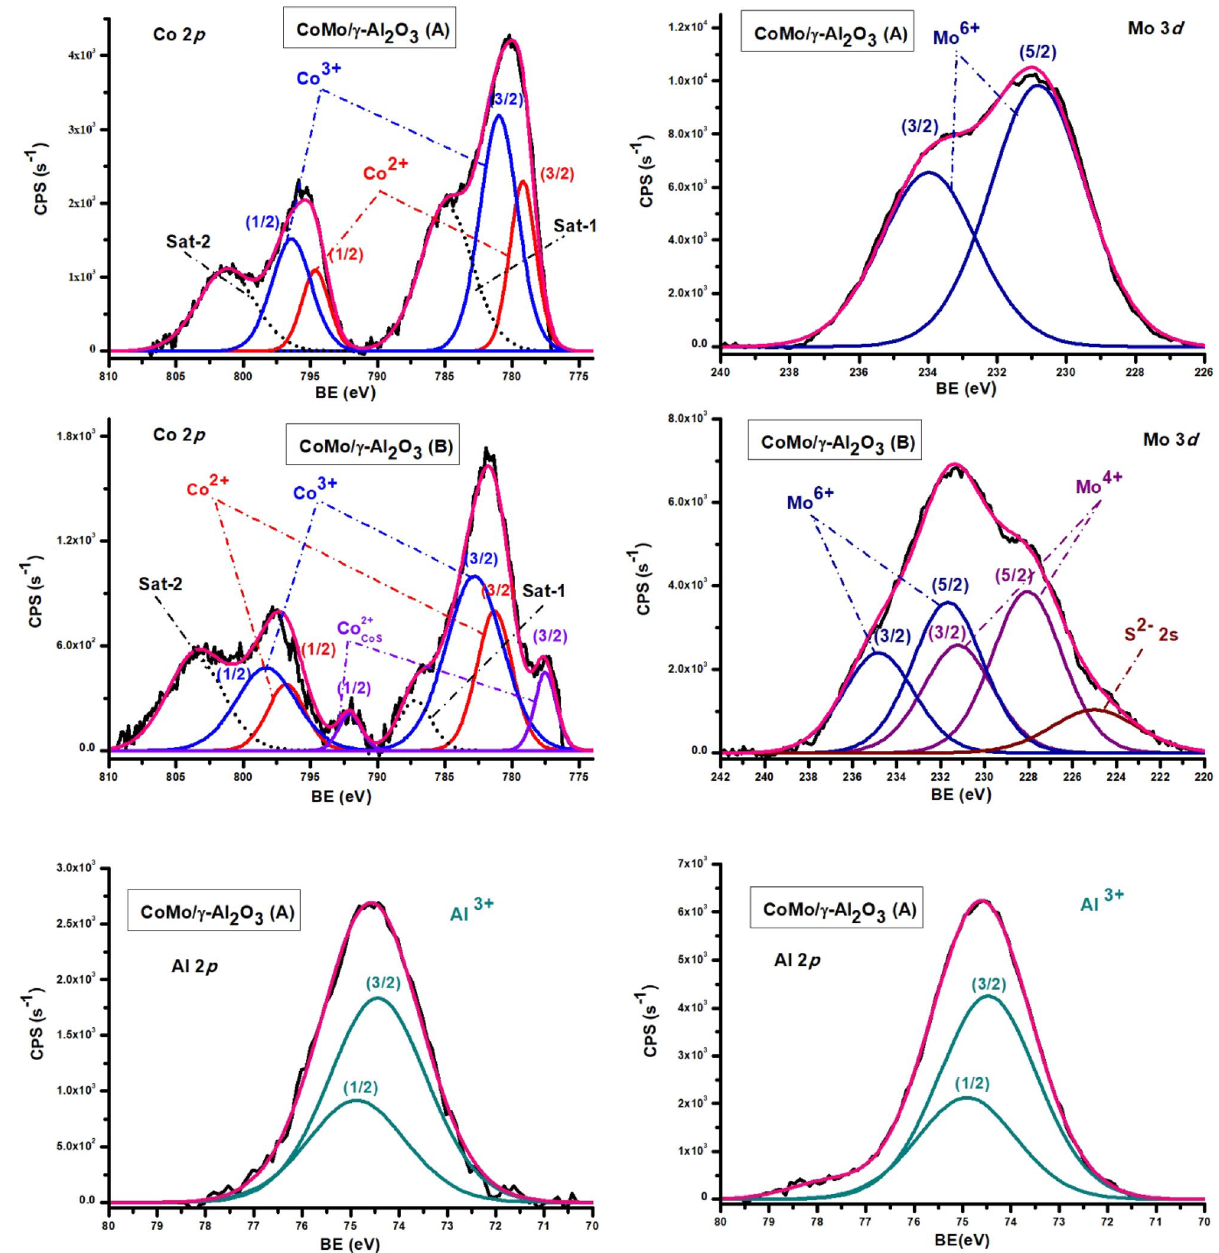
Figure 7. XPS Co 2p, Mo 3d, Al 2p and S 2 s spectra of CoMo/γ-Al 2 O catalyst before ( A ) and after ( B )